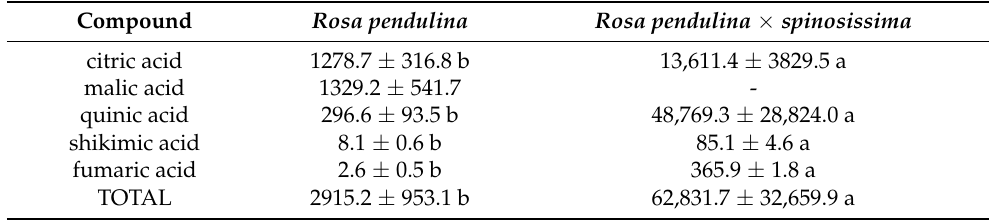
Table 1. The average contents ± standard deviations (mg/kg FW) of organic acids in hips of R. pen- dulina and the hybrid genotype R. pendulina × spinosissima in the region of Western Slovenia in 2020. Different letters signify a statistical difference between the average values of organic acid contents in the hips of R. pendulina and those of R. pendulina × spinosissima .